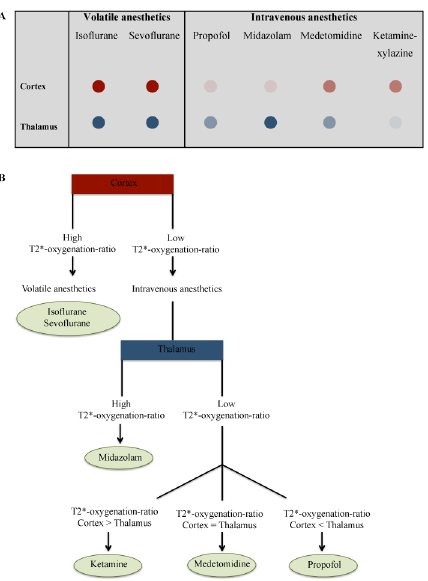
Figure S1 Normality of T2*-oxygenation-ratio. (PDF)